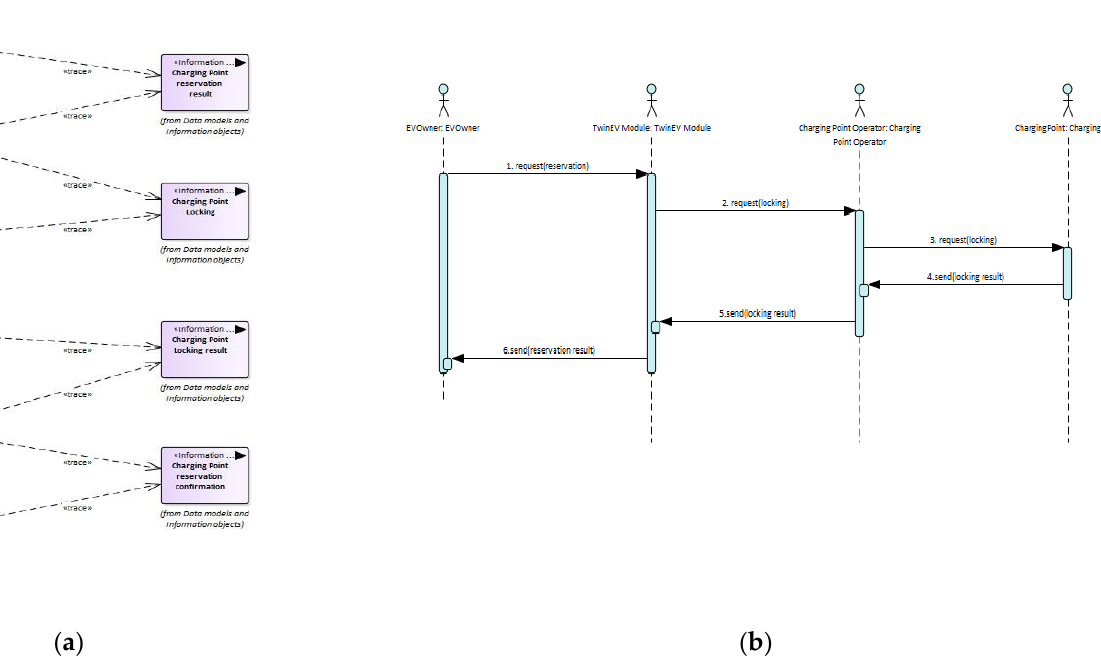
Figure 7. ( a ) SGAM activity diagram of the PUC scenario; ( b ) SGAM sequence diagram of the PUC